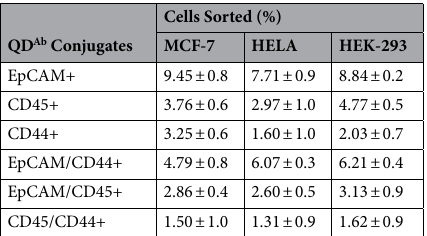
Table 2. Cells captured when treated with respective Antibody Quantum dots